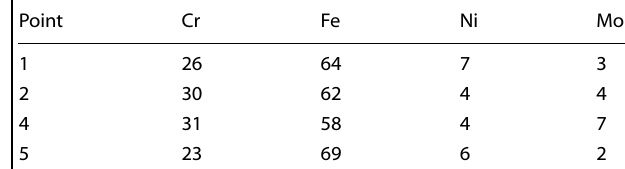
Table 1. Relative concentrations (at.%) at Points 1, 2, 4, and 5 shown in Fig. 5b.